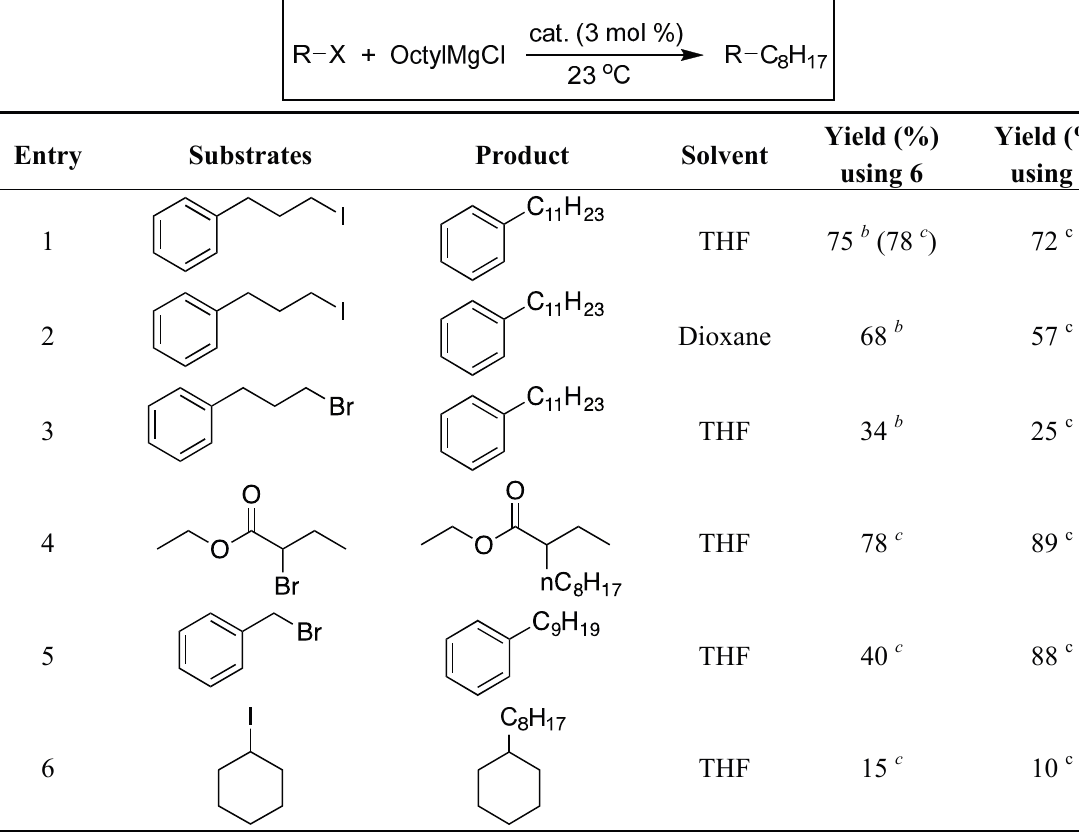
Table 1. Efficiency of alkyl-alkyl coupling reactions with aminophenolate complexes of nickel a .